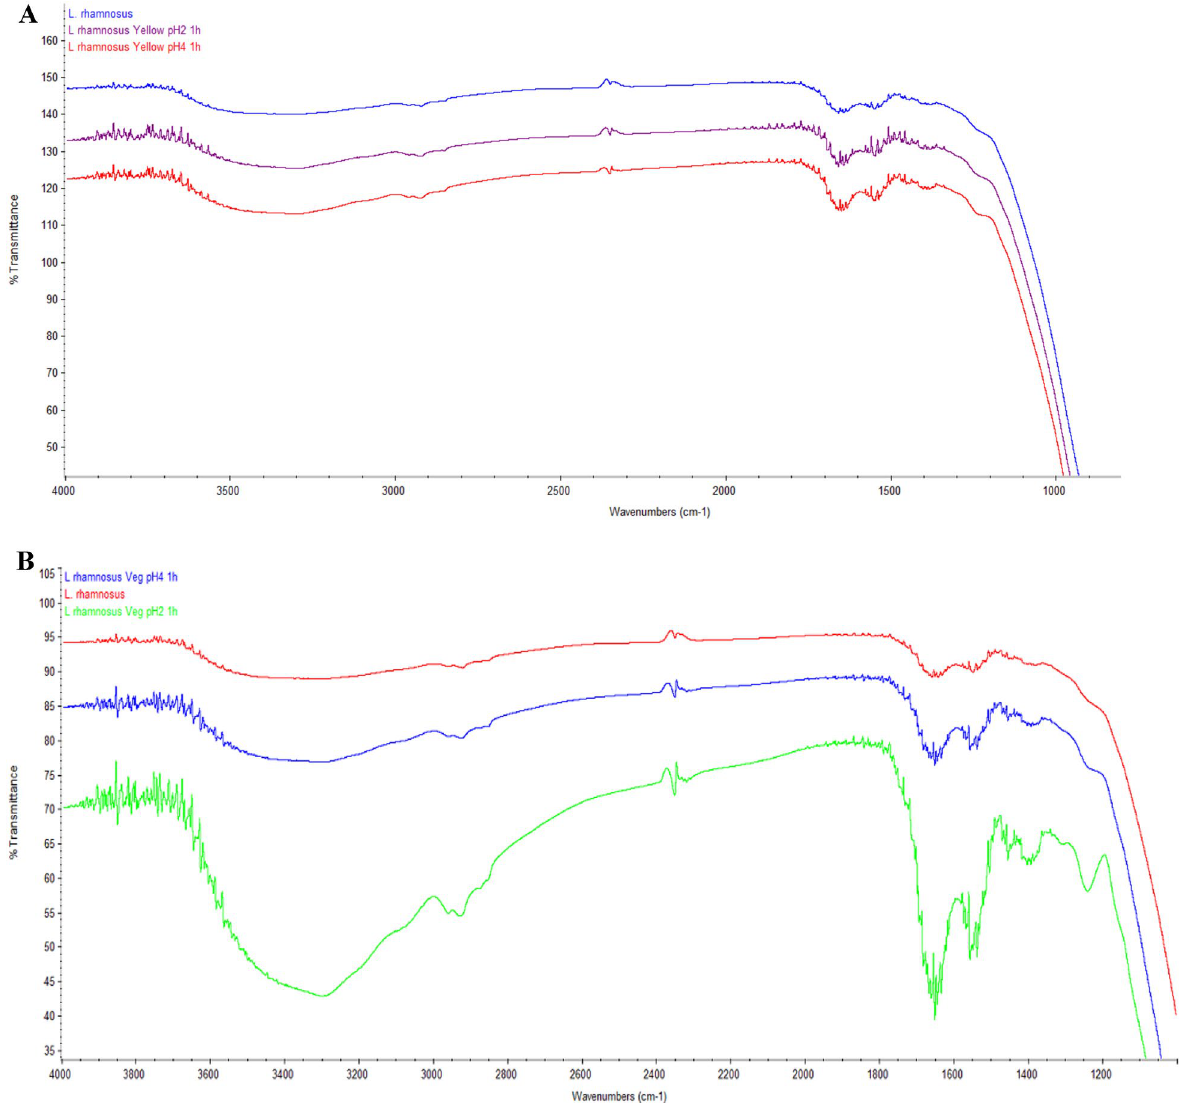
Figure 2. FT-IR spectra of L. rhamnosus LR5 in the stomach with yellow ( A ) and green ( B ) vegetable